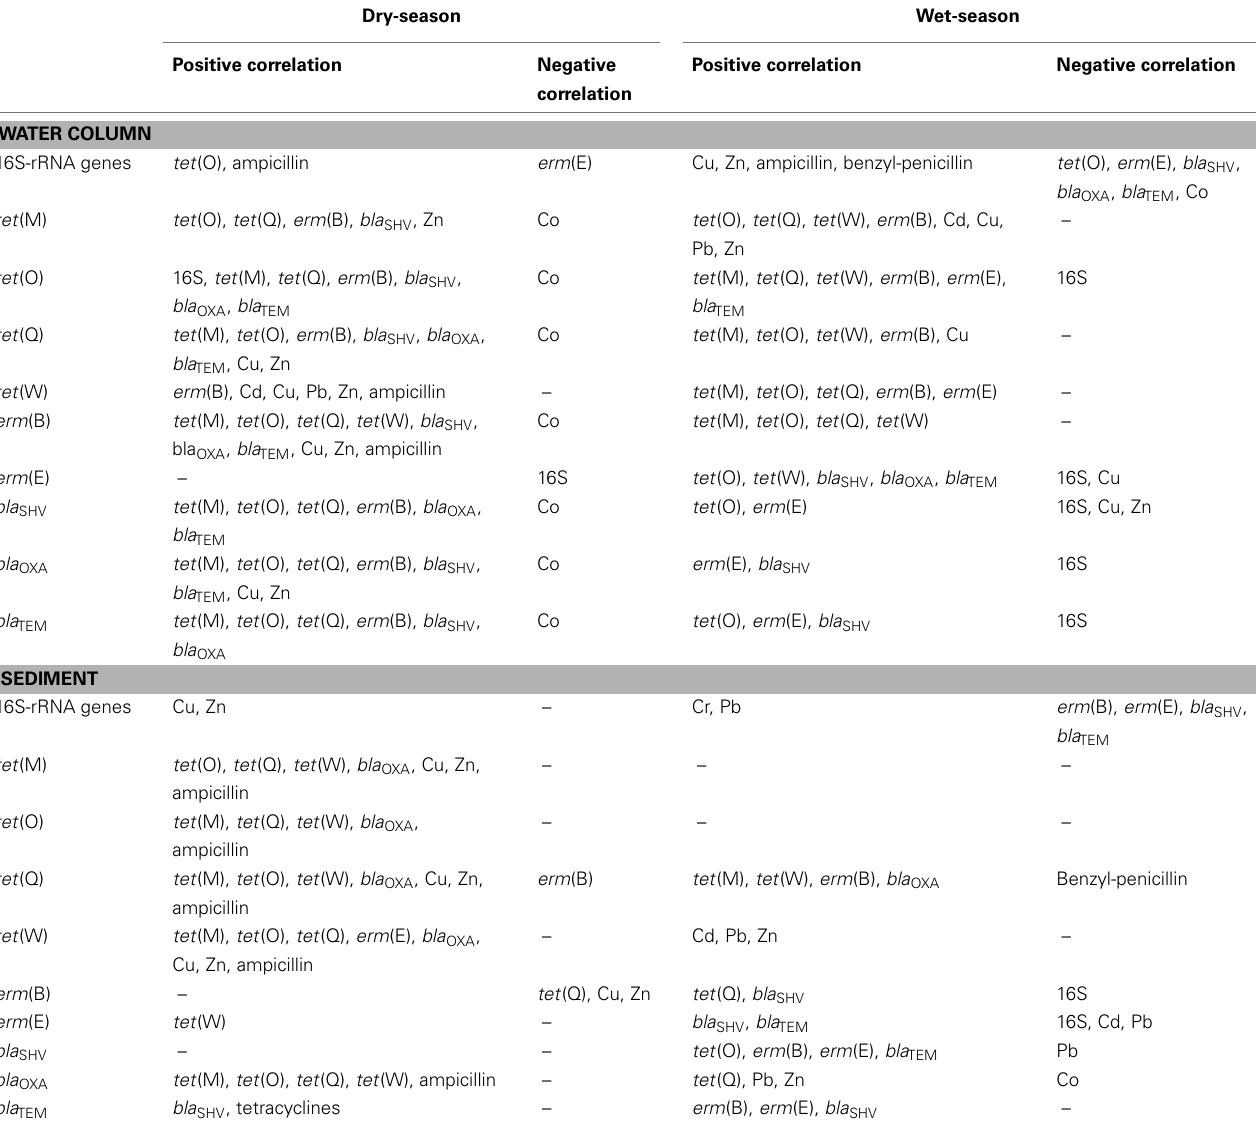
TableA7 | Significant ( p < 0.05) bivariate correlations between 16S-rRNA,ARG, sediment-metal, and water column antibiotic